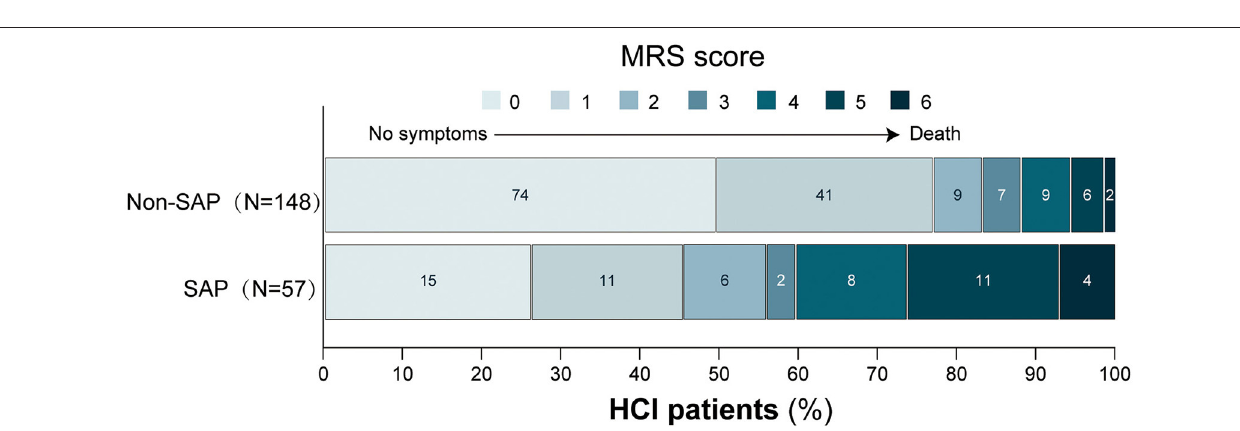
FIGURE 3 | Distribution of MRS scores at 3 months, according to with/without SAP. Scores on MRS range from 0 to 6. The numbers in the cell represent frequencies. The y-axis measures the cumulative proportion of MRS scores. MRS, modified Rankin scale; SAP, stroke-associated